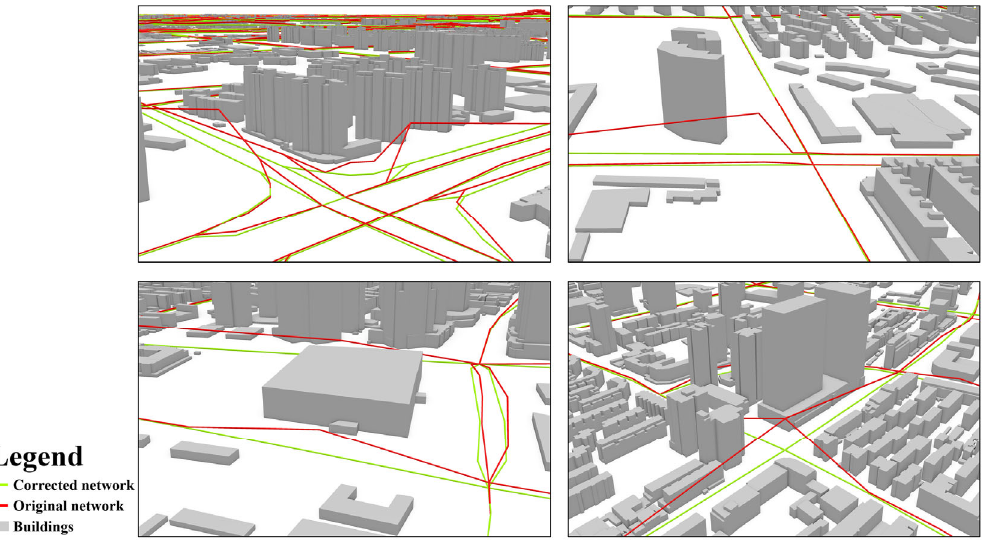
Figure 11. A comparison of corrected road network (green line) and original road (red line) in urban areas.